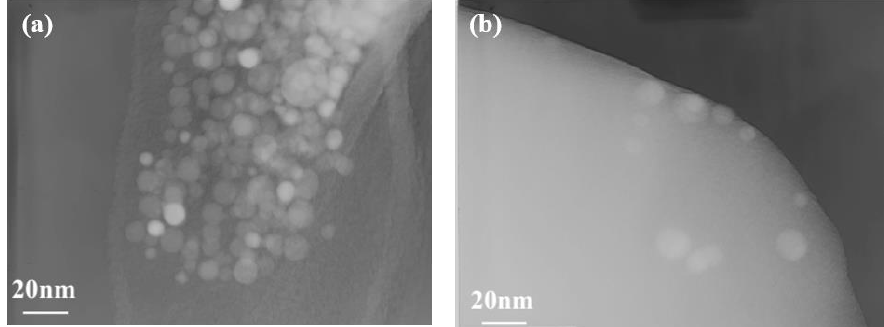
Fig. 3. TEM images of metal nanoparticles from a) p(AMPS-Na + - co -VIm)-Ag and b) p(AMPS-H + - co -VIm)-Ag.